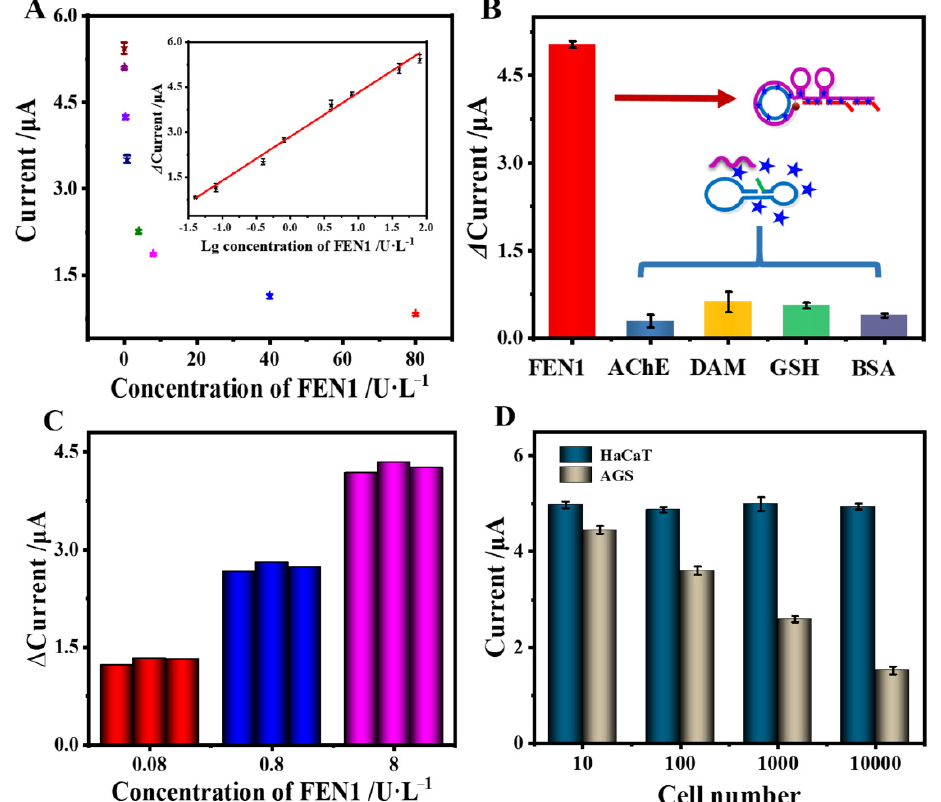
Figure 3. ( A ) Relationship between DPV peak current and FEN1 concentration. Insert: Calibration curve between ∆ Current and the logarithm of the target FEN1 concentration. ( B ) Selectivity of the proposed homogeneous electrochemical biosensor in the presence of 8 U/L FEN1 and other interferences. ( C ) Reproducibility of the proposed electrochemical biosensor. ( D ) Test in the cell lysates of HaCaT and AGS cells by the proposed sensor. The error bars show the standard deviation of three replicate determinations.